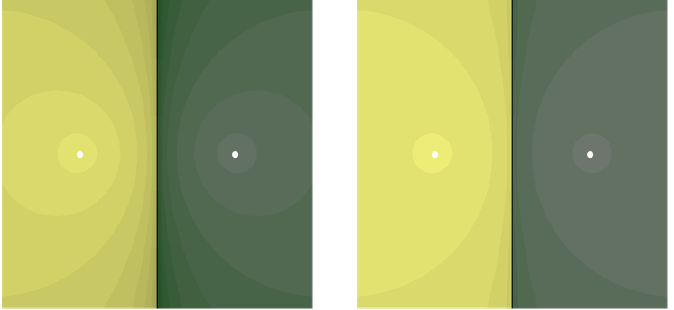
Figure 5. Basins of attractions for (5) on left, (12) on right.